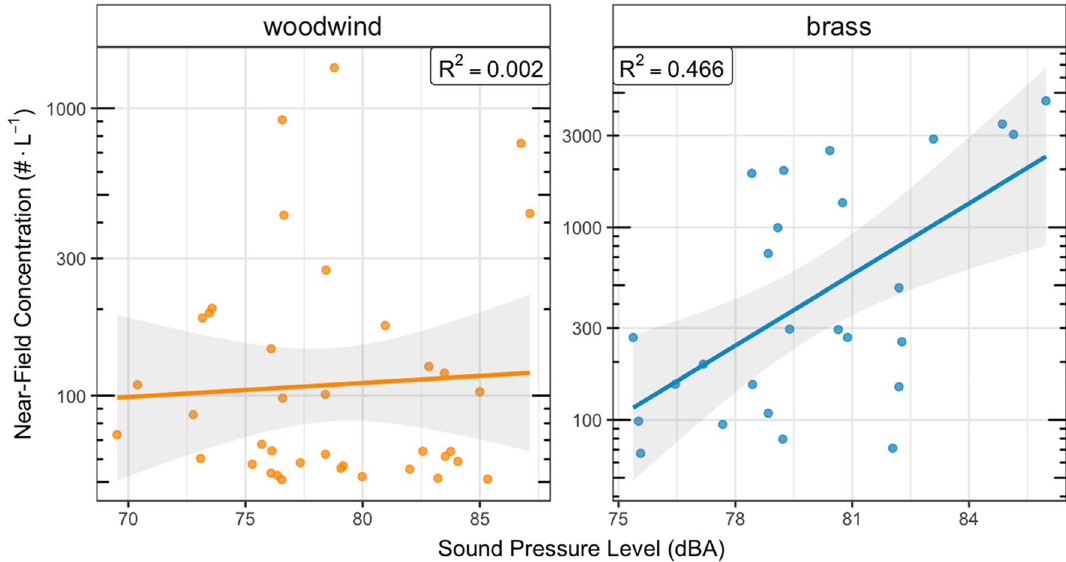
Figure 3. Correlation between instrument sound pressure level and aerosol number emission rates (0.25– 35.15 μm size range), stratified by instrument class. All data are background corrected; correlations consider only measurement data above method detection limit.